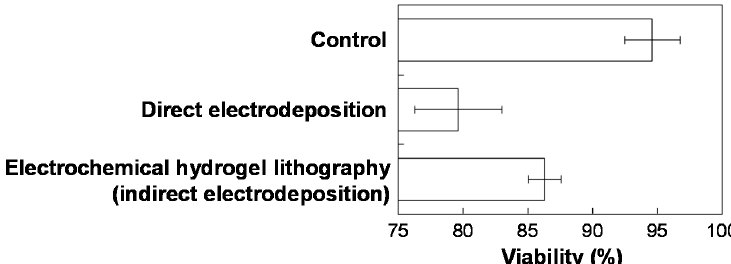
Figure 3. Cell viability using a conventional culture method (control), the previous electrodeposition method (Figure S2), and electrochemical hydrogel lithography (indirect electrodeposition).